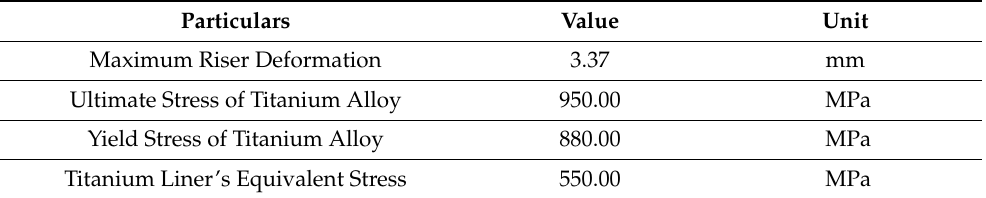
Figure 13. Stress profiles for the top, middle, and bottom lamina along the ( a ) fibre and ( b ) transverse directions under burst case. Table 8. Riser deformation and liner stress during burst event’s preliminary